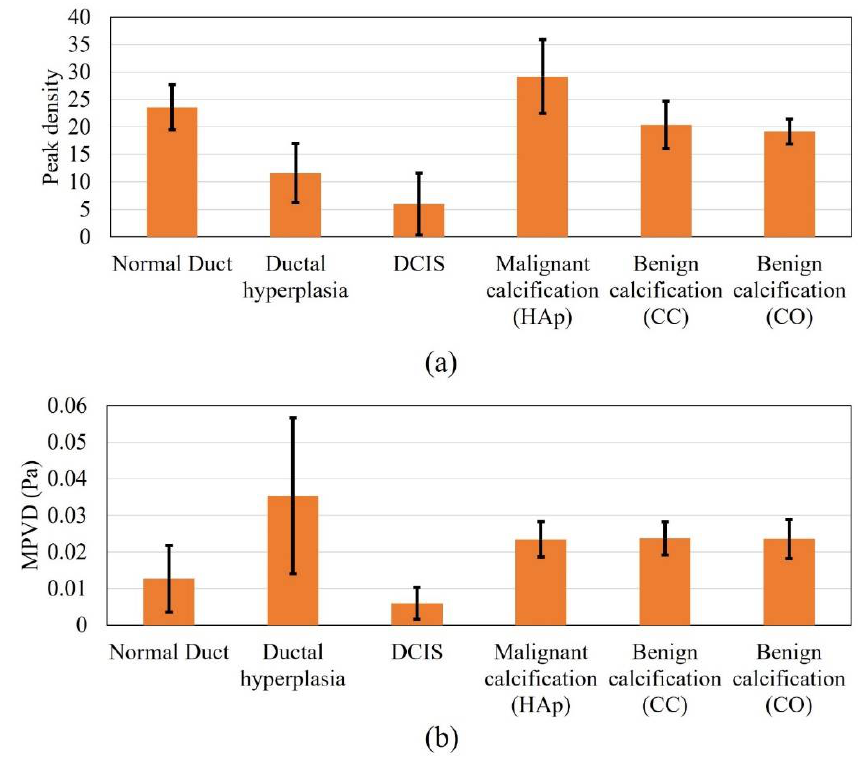
Figure 4. Response values of all the analyzed models in pitch-catch mode: ( a ) peak density and ( b ) MPVD.